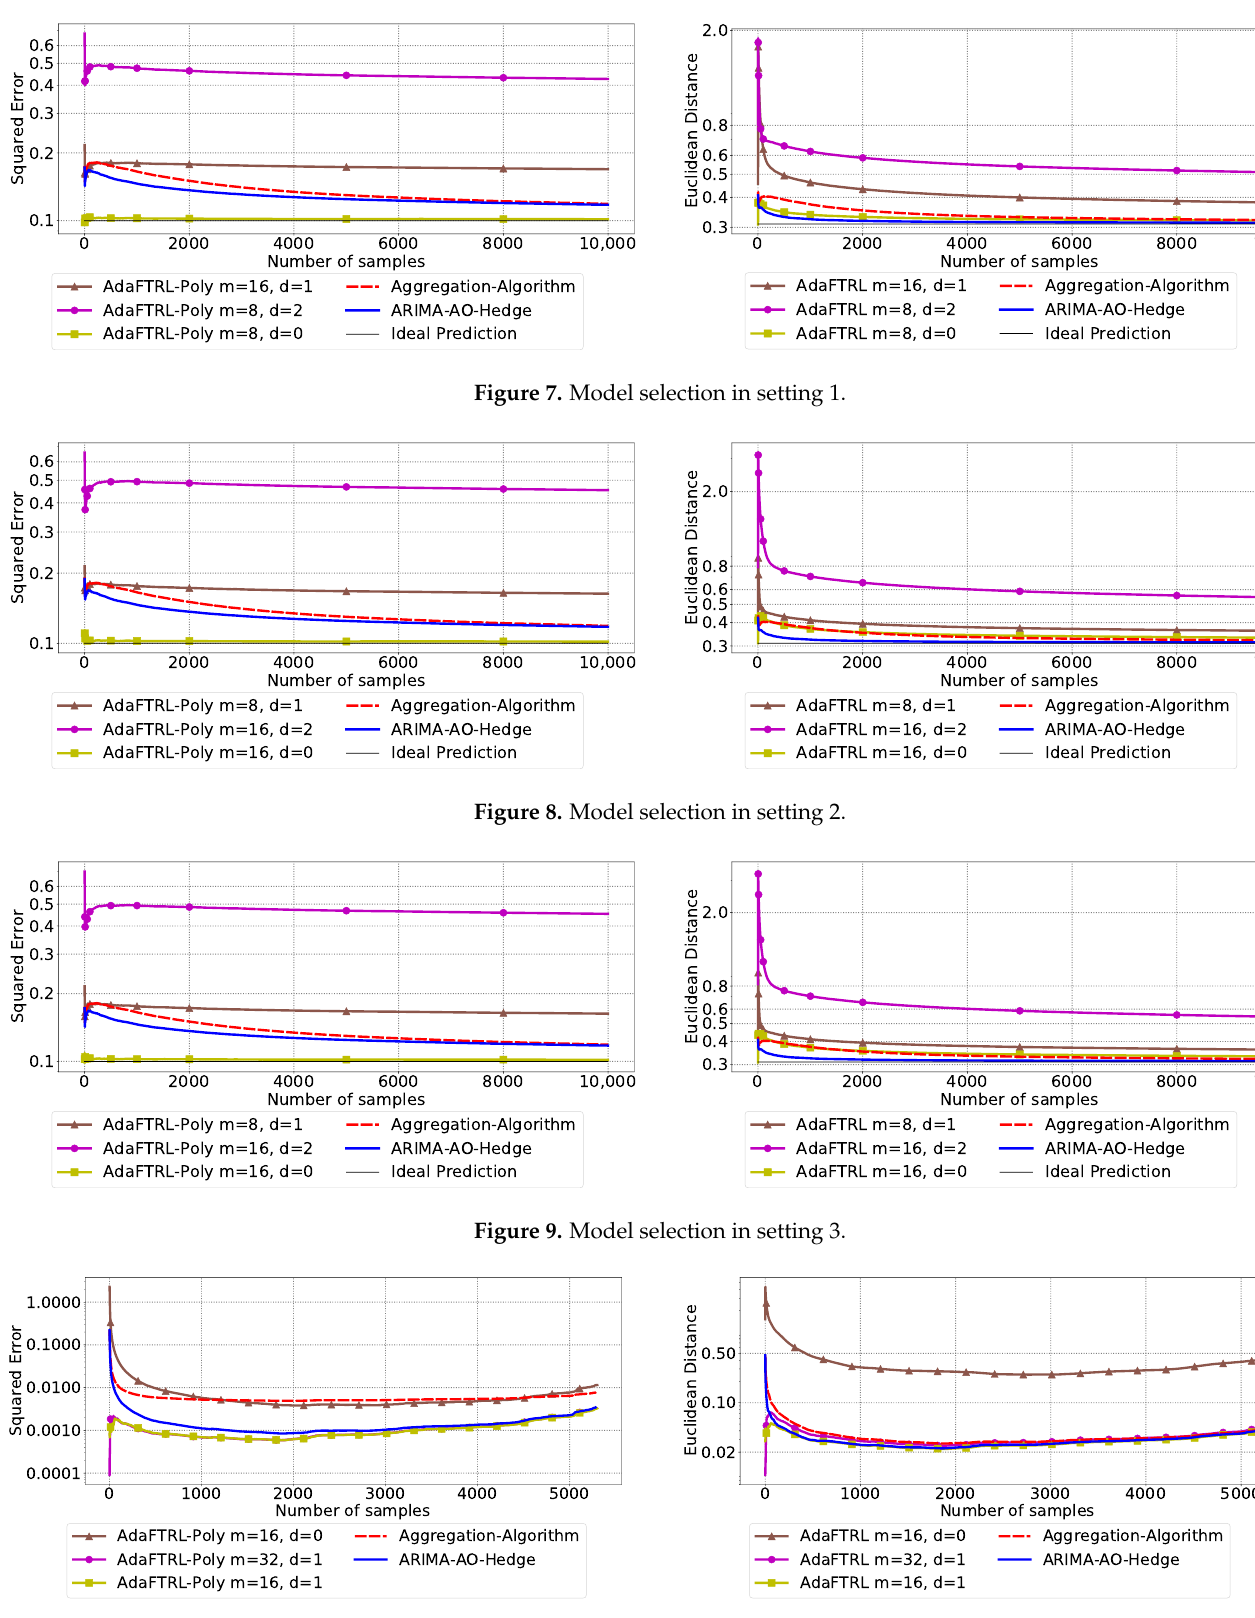
Figure 10. Model selection for stock